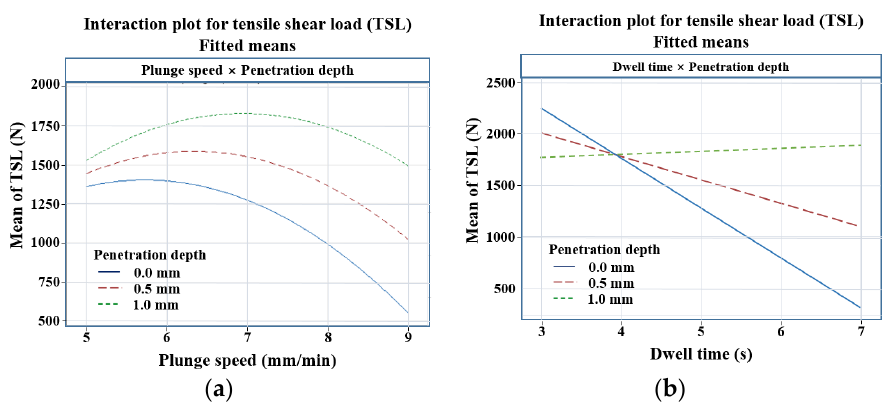
Figure 4. Interaction plot for tensile shear load. ( a ) Penetration depth and plunge speed; ( b ) penetration depth and dwell time.